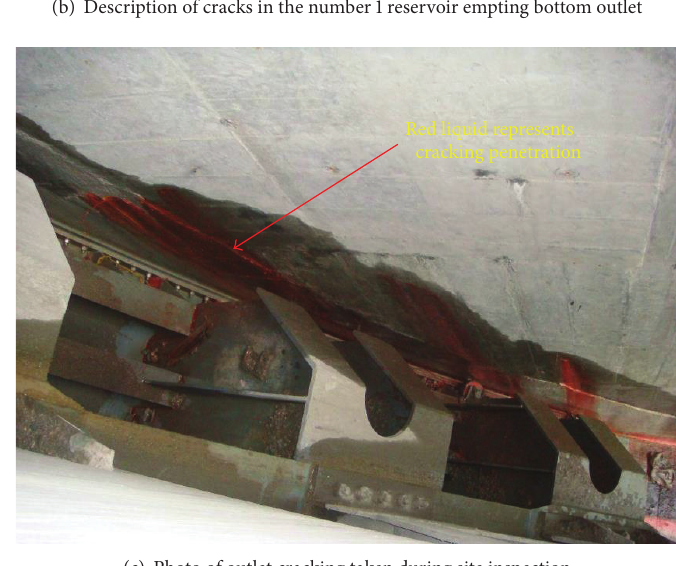
hereafter includes filling in cracks using preshrinkage mortar, drilling stress release hole, and installing double-layer crack- limiting steel bar. After the construction of the bottom outlets but before the grouting of the transverse joint in the number 9 grouting zone (from EL 479.0 m to EL 488.0 m), all the bottom outlets are examined and new second series of cracks are found in the side walls and floors, as